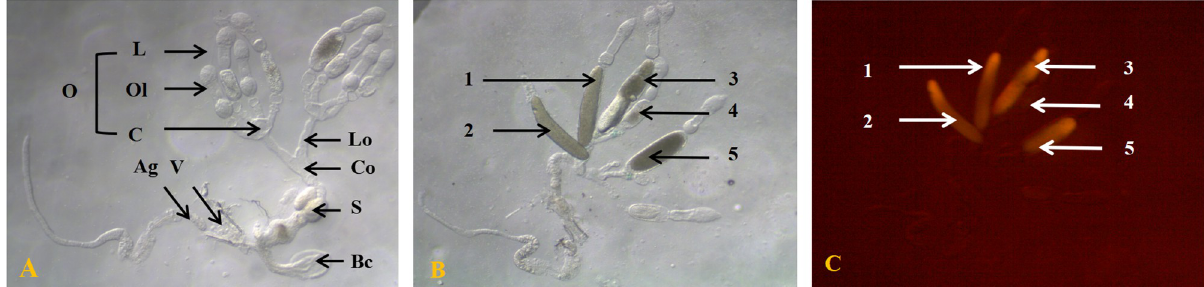
Fig 2. The inner reproductive system of Matsumurasca onukii female adult under stereomicroscopy with cold light (A, B) and with blue light (C). L, terminal filament; C, ovarian calyx; Ol, ovariole; O, ovary; S, spermatheca; Ag, accessory gland; Lo, lateral oviduct; Co, common oviduct; Bc, bursa copulatrix; V, vagina; 1 and 2 were mature oocytes; 3, 4, and 5 were immature oocytes.